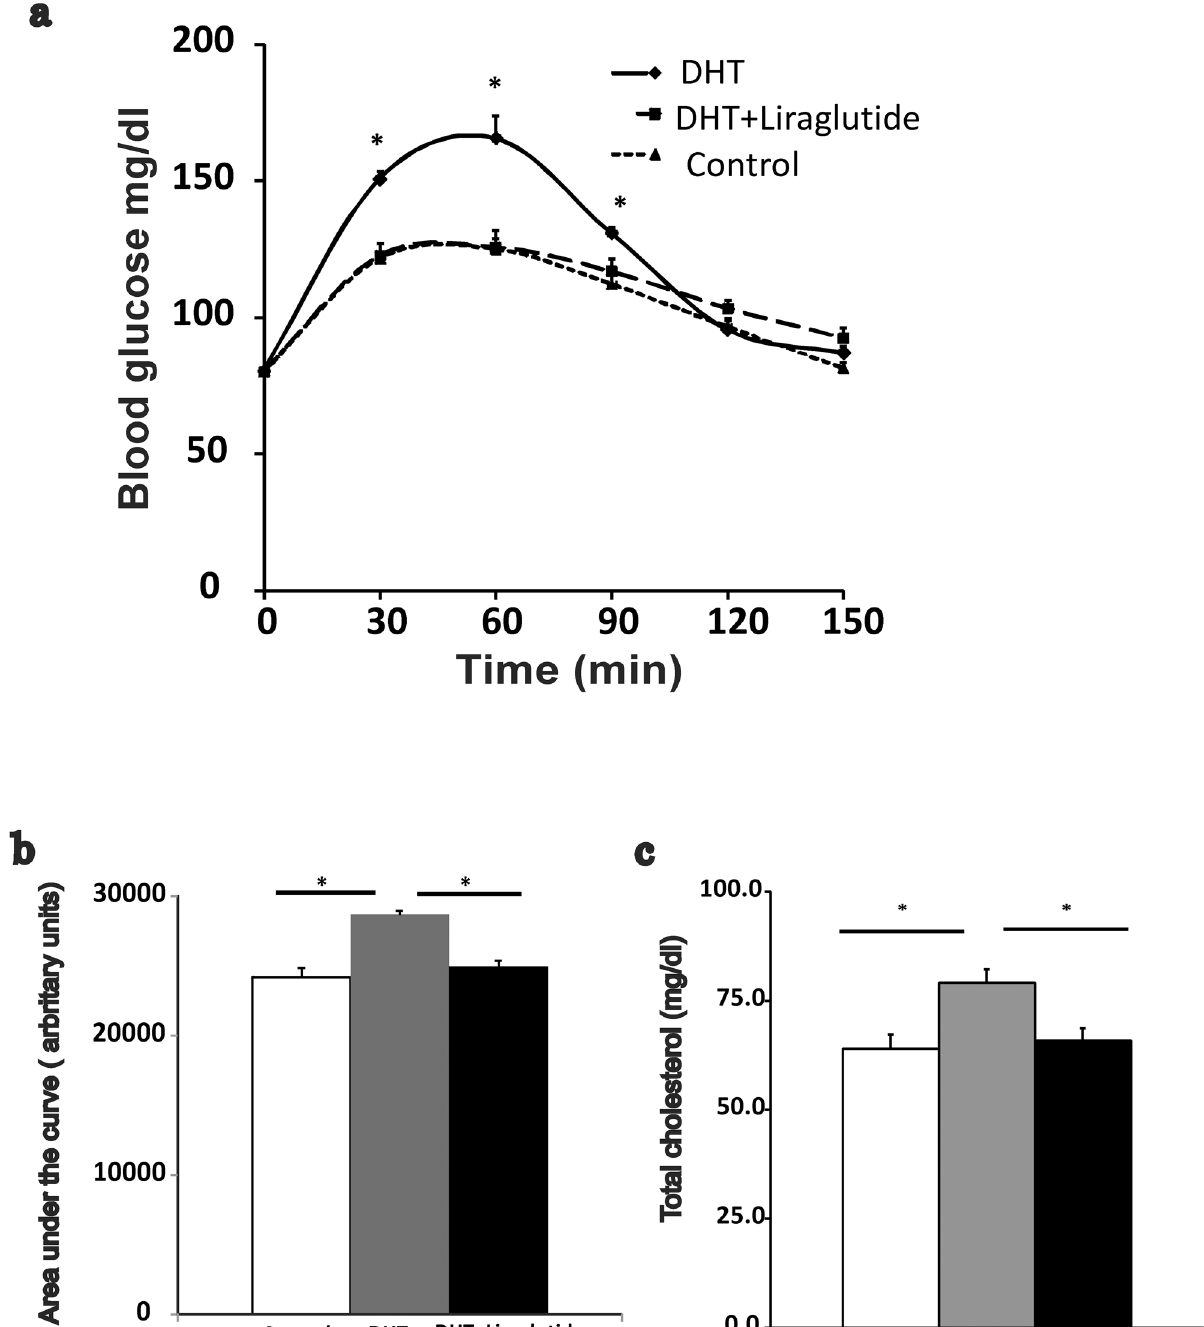
Fig 4. Effect of liraglutide on DHT induced metabolic perturbation. (Mean ± SEM): a) oral glucose tolerance test done at 16 weeks (n = 9 control, n = 8 DHT+liraglutide and n = 10 DHT). b): Area under the curve during OGTT for different groups. c): Total cholesterol measured at the end of the study (88 – 90 days from pellet/sham implantation) after 10 hour fast (n = 8 rats in DHT and DHT+ liraglutide group and n = 5 in control group). * denotes p < 0.05 between DHT and DHT+ liraglutide and DHT and control.